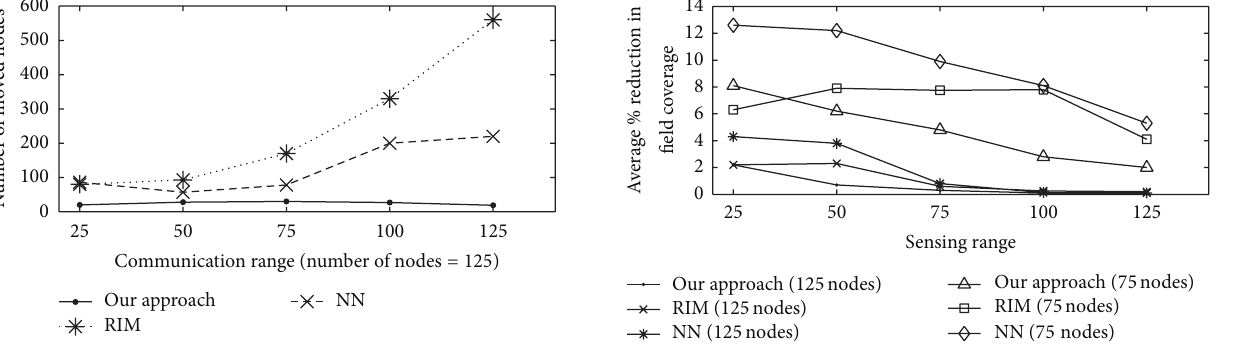
Figure 8: Reduction in field coverage versus sensing range (m) for 75 and 125 nodes.